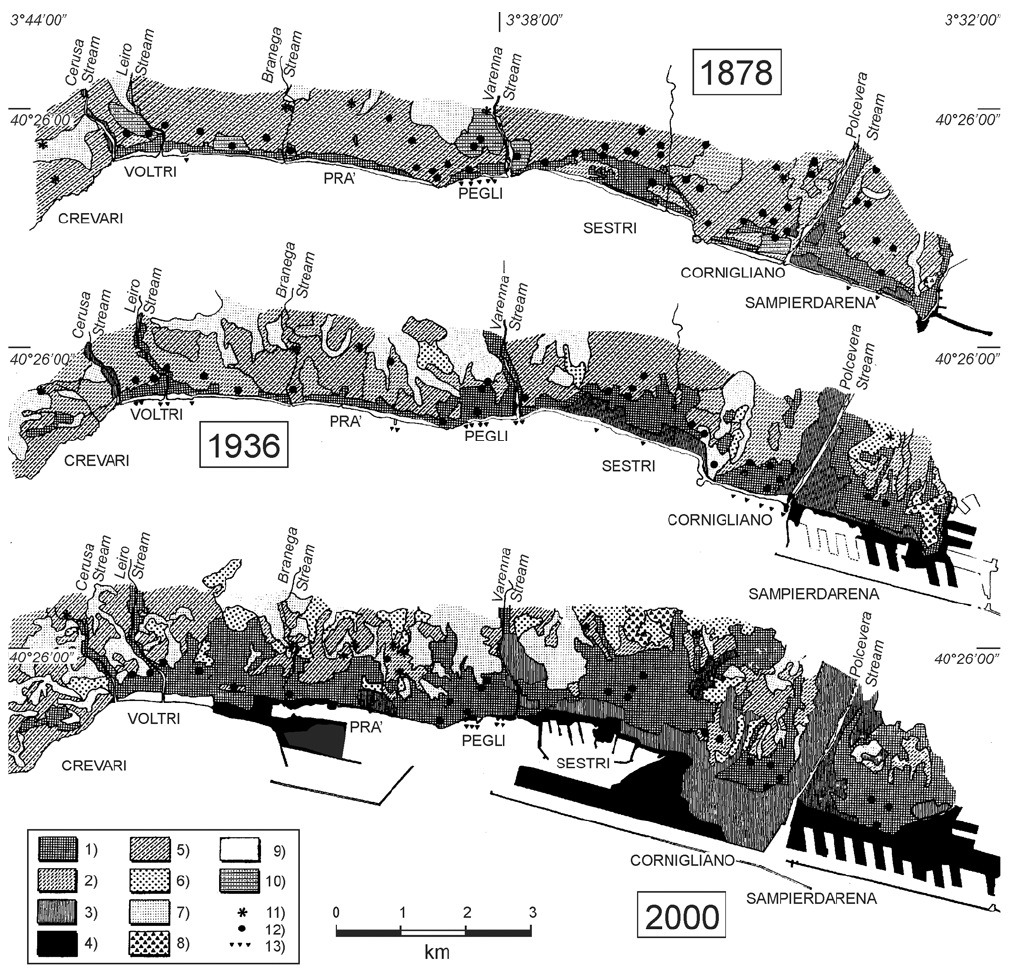
Fig. 7. Land use changes in the middle-western sector of the Genoa Municipality, affected by major morphological modifications in the 1878– 2000 period: (1) urban settlements; (2) sparse settlements in cultivated areas; (3) industrial settlements; (4) harbour and airport settlements; (5) cultivated areas; (6) abandoned cultivated areas; (7) wooded areas; (8) quarry areas; (9) beaches; (10) urban gardens (only in 1878 map); (11) isolated residential areas; (12) villas and/or villas with garden; (13) coastal defences (modified from Brandolini et al.,